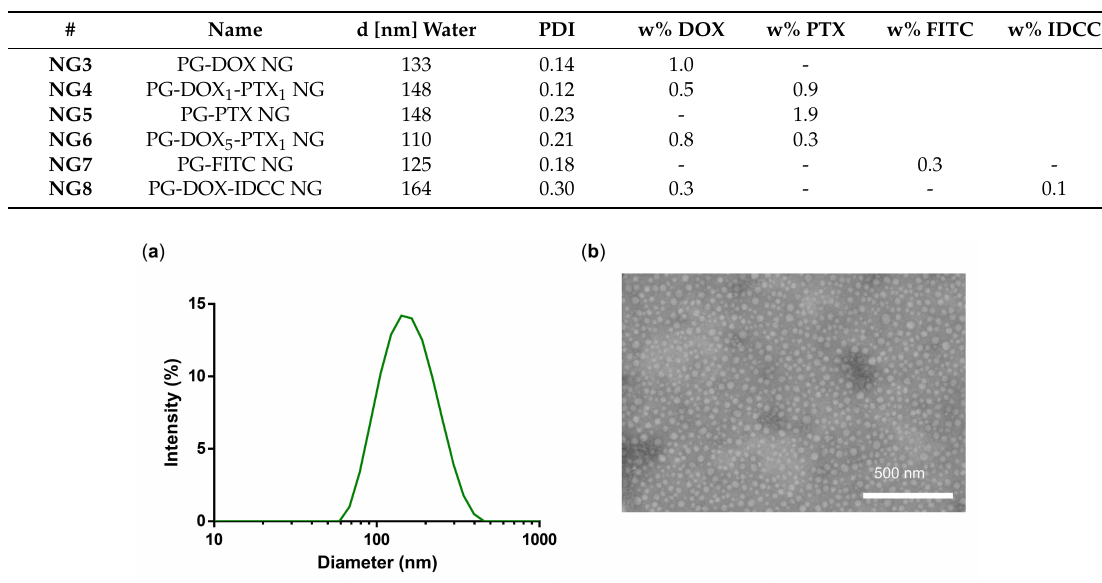
Figure 6. ( a ) DLS intensity size distribution and ( b ) TEM of NG4.